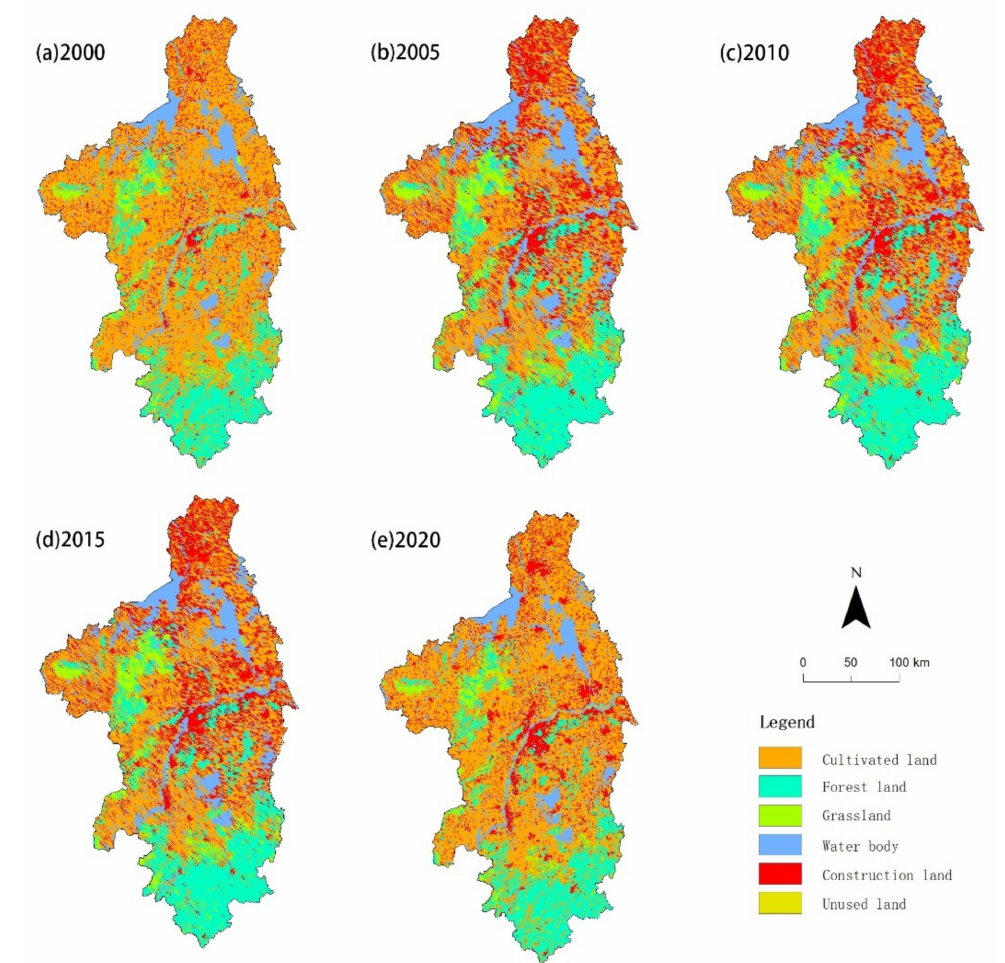
Figure 2. Maps of land use in the Nanjing metropolitan area from 2000 to